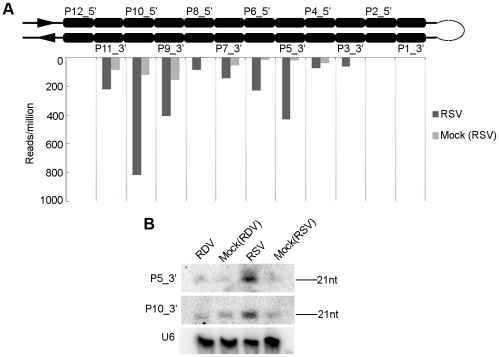
Induction of OsDCL4-dependent phased 21-nt siRNAs produced from the long hairpin of RNA encoded by the AK120922 locus in RSV-infected rice.(A) Accumulation of siRNAs in RSV-infected rice compared that in mock-inoculated rice. The upper structure illustrates the long RNA hairpin. The read numbers below the hairpin, which were each normalized to one million with total reads of the corresponding library, indicate the expression levels of siRNAs at corresponding positions in the 3′ arm of the hairpin. (B) RNA gel blots confirm accumulation of the highly induced P10_3′ and P5_3′, hybridized with the complementary 32P-labeled probes.